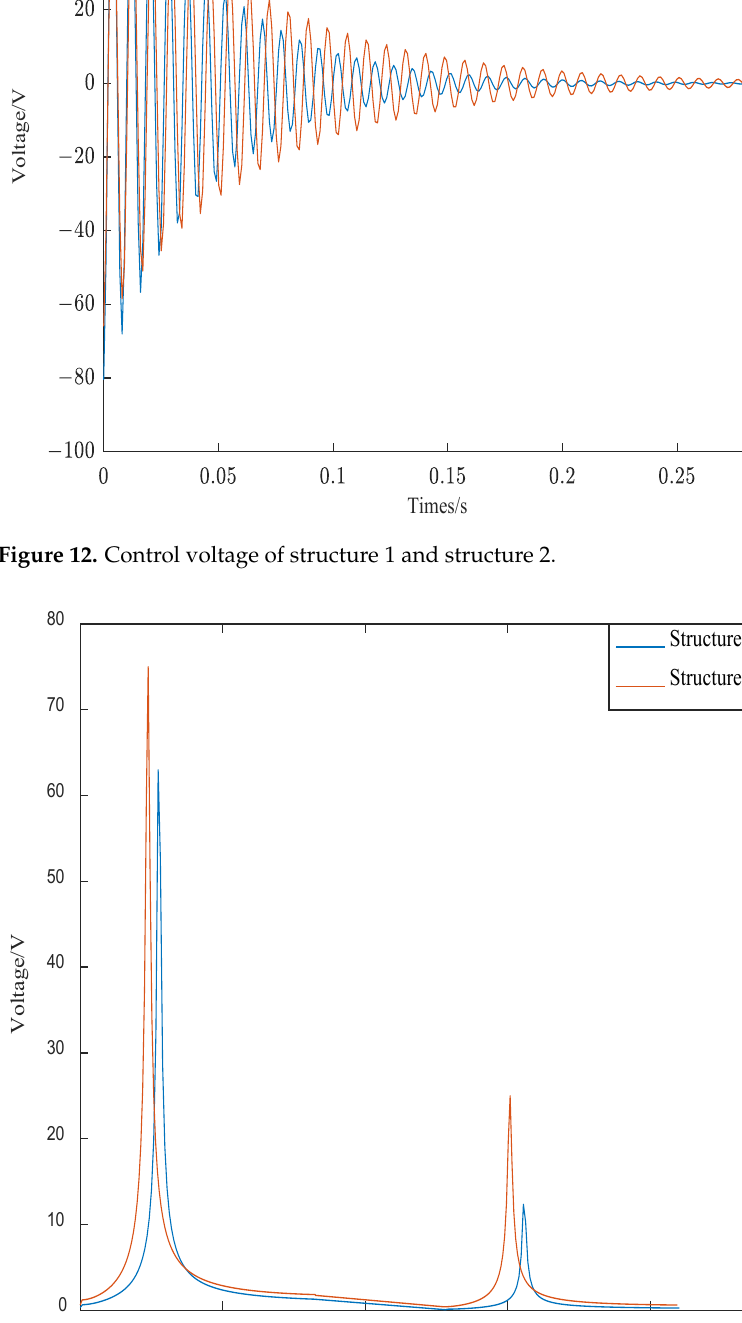
Figure 12. Control voltage of structure 1 and structure 2.